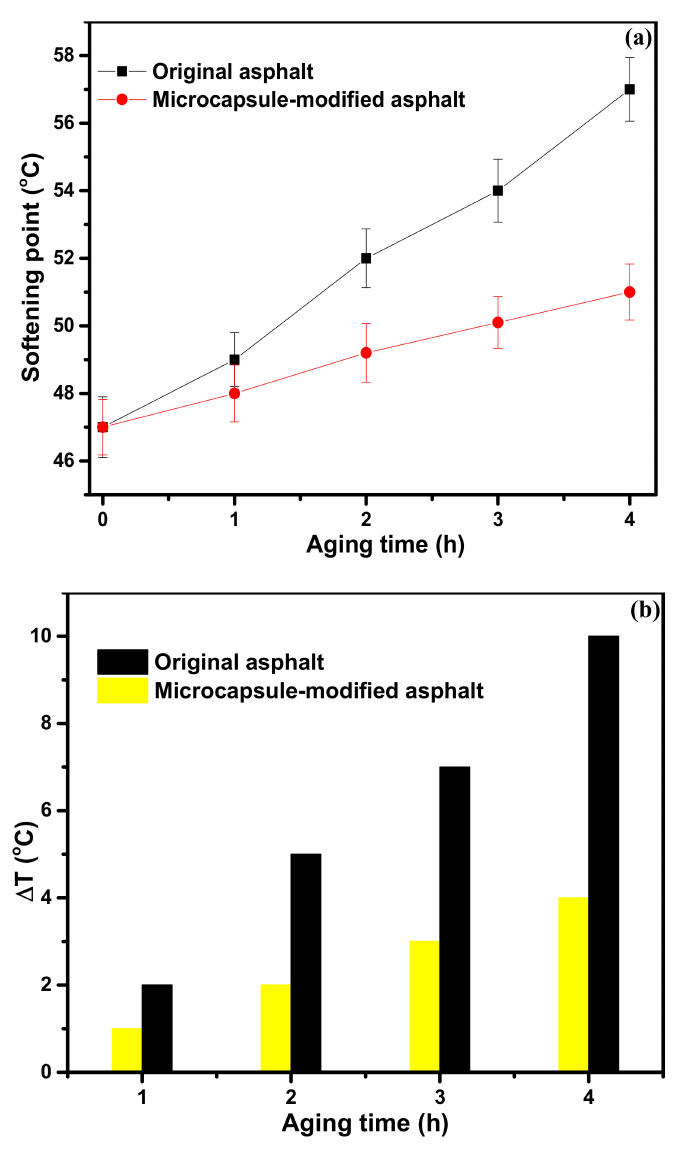
Figure 8. The softening point versus the aging time of different asphalt samples ( a ); the increment of softening point ( ∆ T ) versus the aging time of different asphalt samples ( b